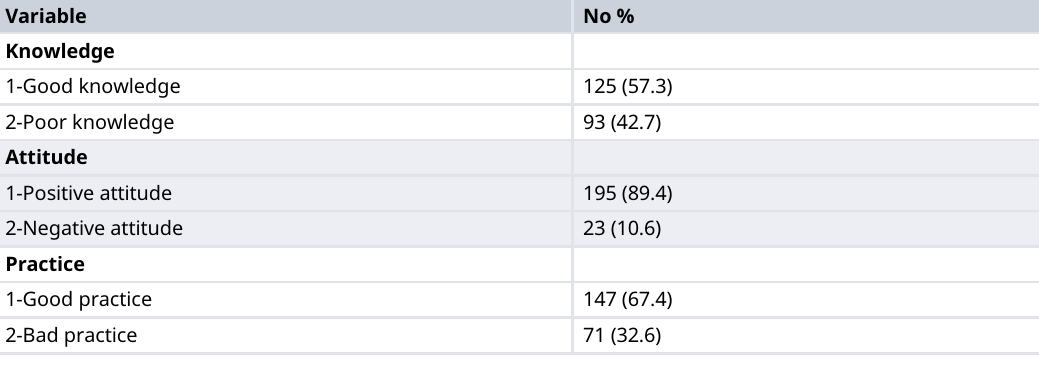
Table 2. The knowledge, attitude, and practice level of dental auxiliaries regarding oral health care for pregnant patients in the Eastern Province of Saudi Arabia (2021).